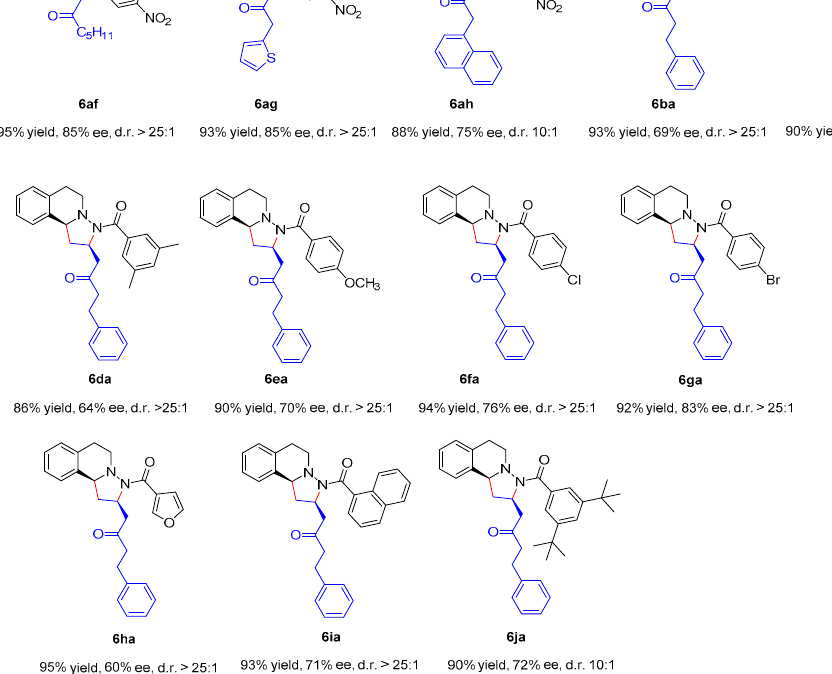
Figure 2. Substrate scope of the double 1,3-dipolar cycloaddition a . a Unless noted otherwise, reactions were performed with 4 (0.1 mmol), 5 (0.2 mmol), amine C2 (10 mol%), and OFBA (20 mol%) in DCE (1 mL) at rt.